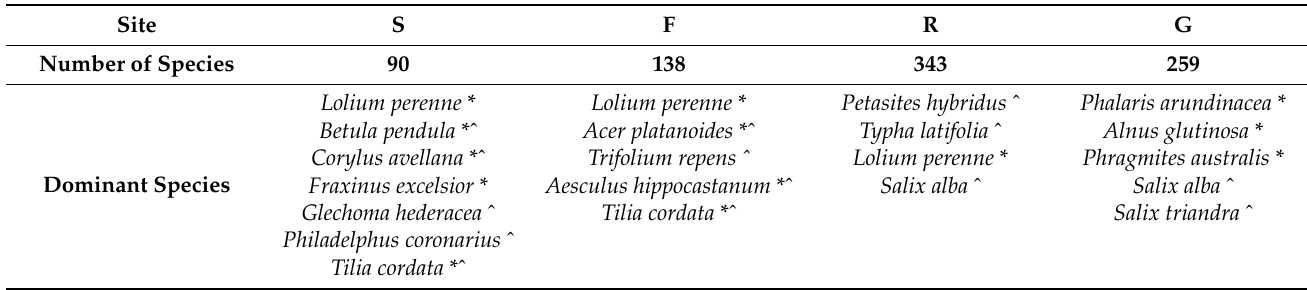
Table 2. Number and dominant species in the study sites.